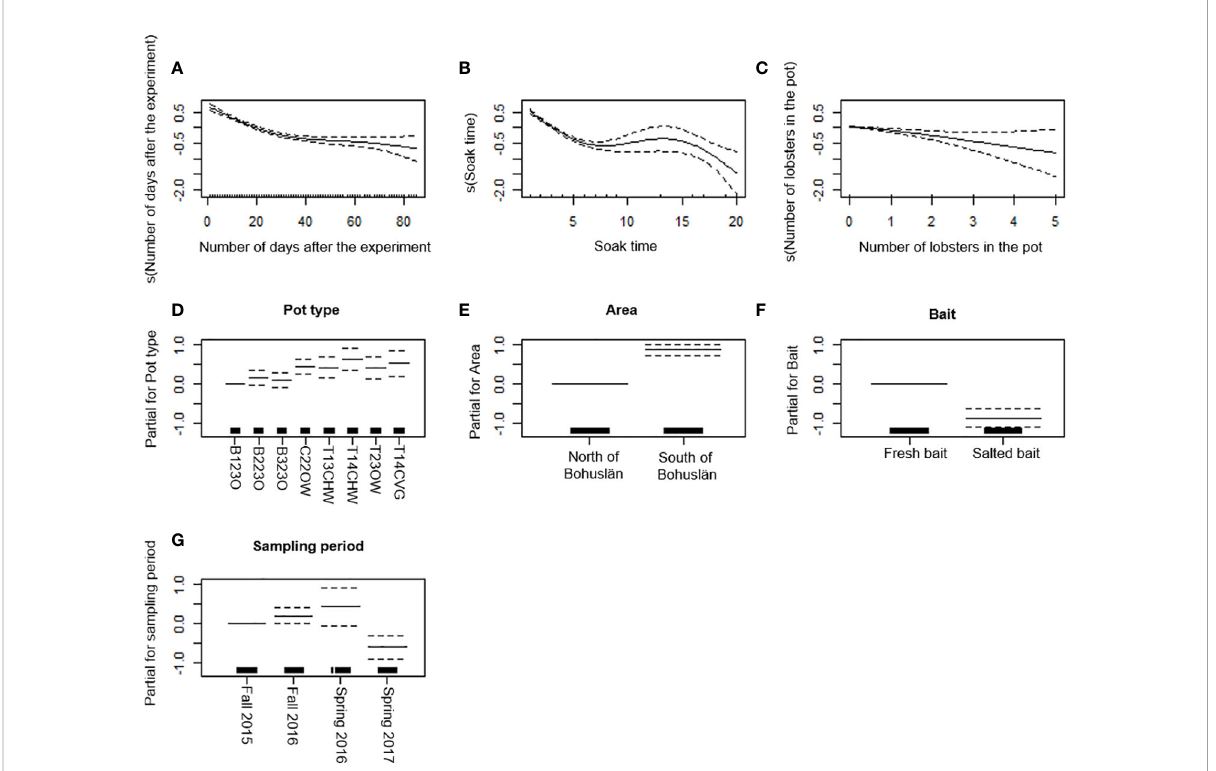
FIGURE 5 Generalized additive model (GAM) partial dependence plots for edible crab. (A-C) Partial response curves: the x-axis represents the value of the model independent variable whereas the y-axis represents the additive contribution of the variable to the nonparametric GAM smoothing function. Values below zero indicate a negative effect of the variable on the CPUE. (D-G) Partial effects of pot type, area, bait, and sampling period on the CPUE. The dotted line (A-G) represents the 95% con fi dence interval. The black lines on the x-axis represents sample